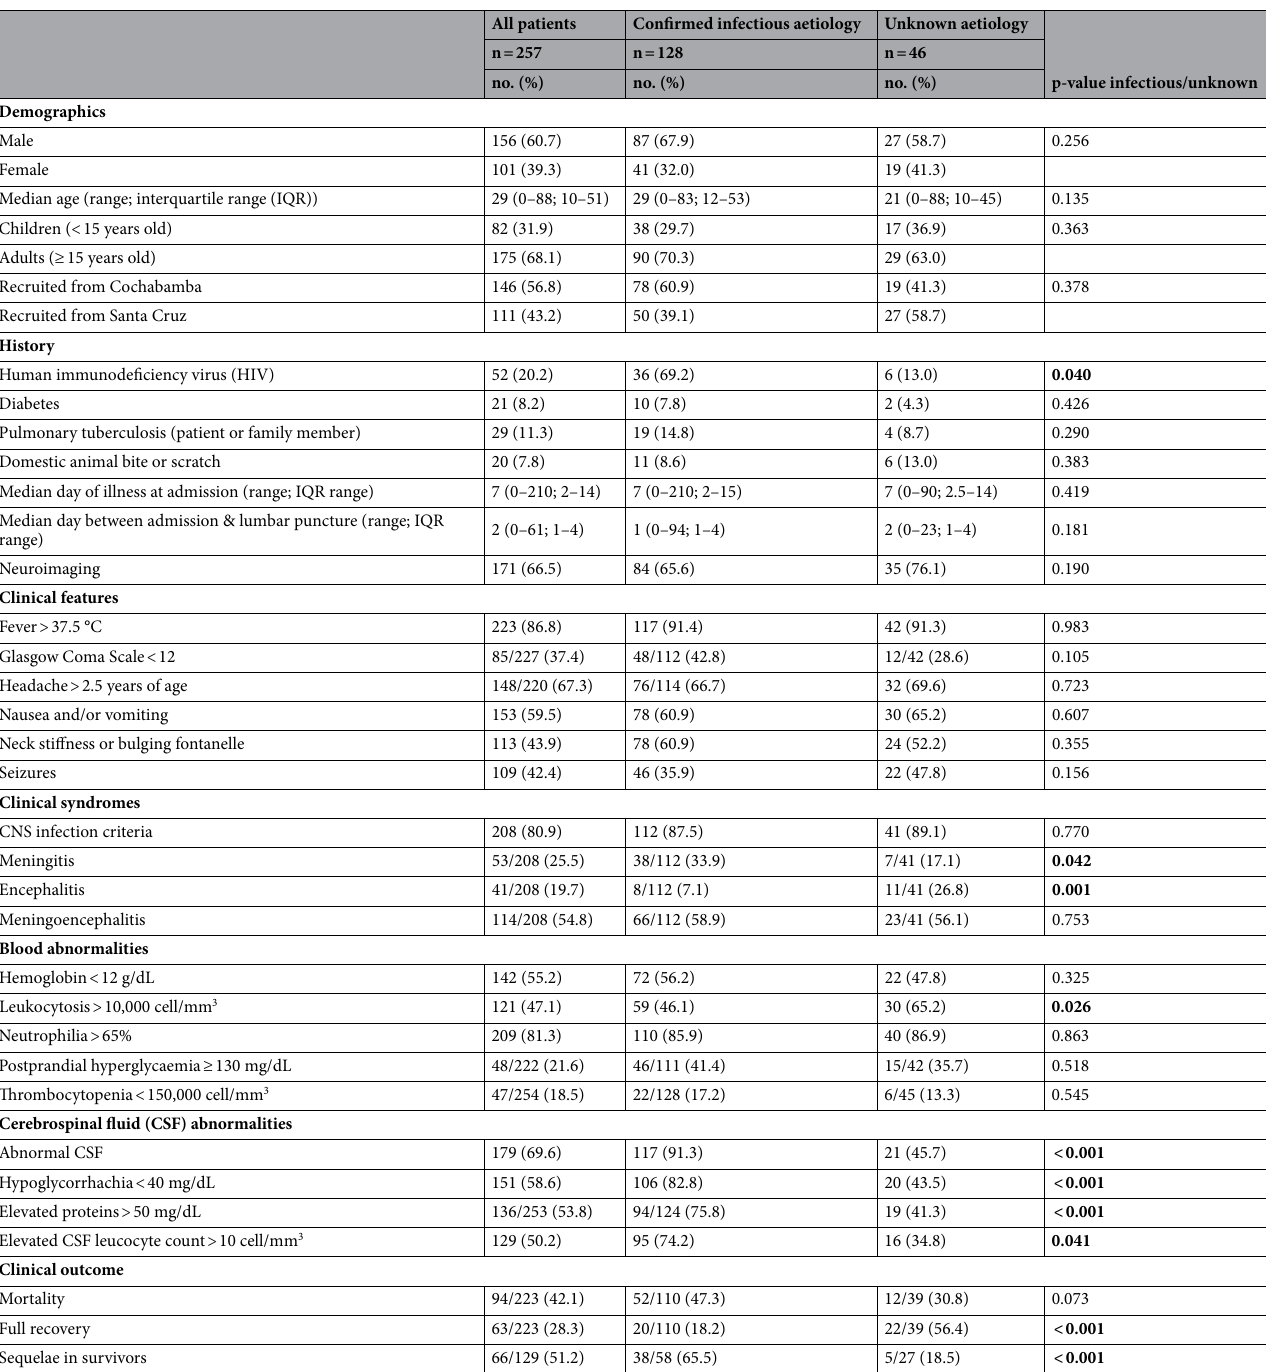
Table 1. Characteristics of patients with suspected central nervous system infection by confirmed infectious aetiology and unknown aetiologies. Bolivia, 2017–2018. Data are presented as mean (range and interquartile range), or number (%). Significant values are in